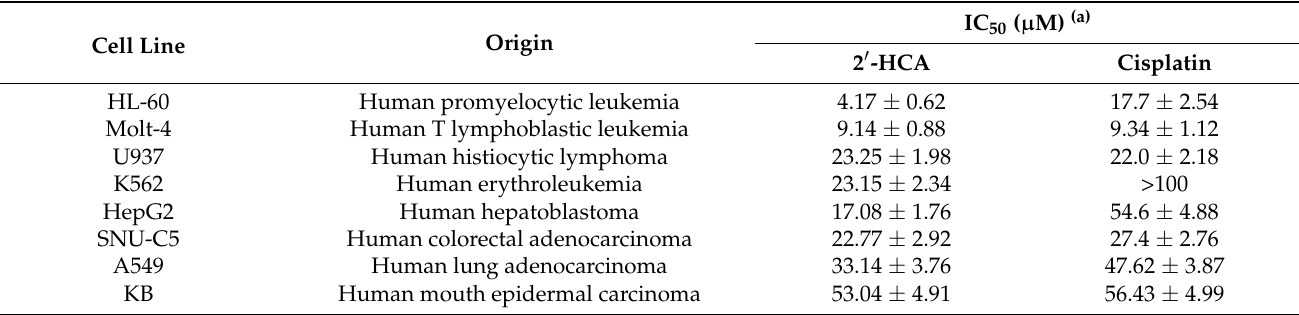
Table 1. Effect of 2 (cid:48) -HCA on cancer cell growth in